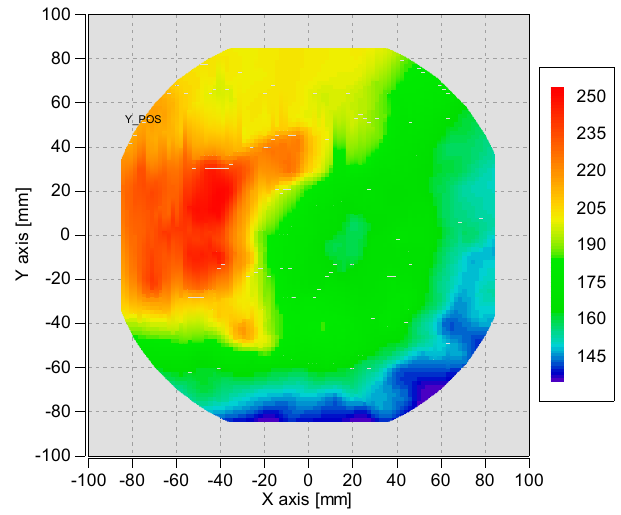
Figure 4. Calculated NH 3 concentration [ppm] at the SCR inlet face.